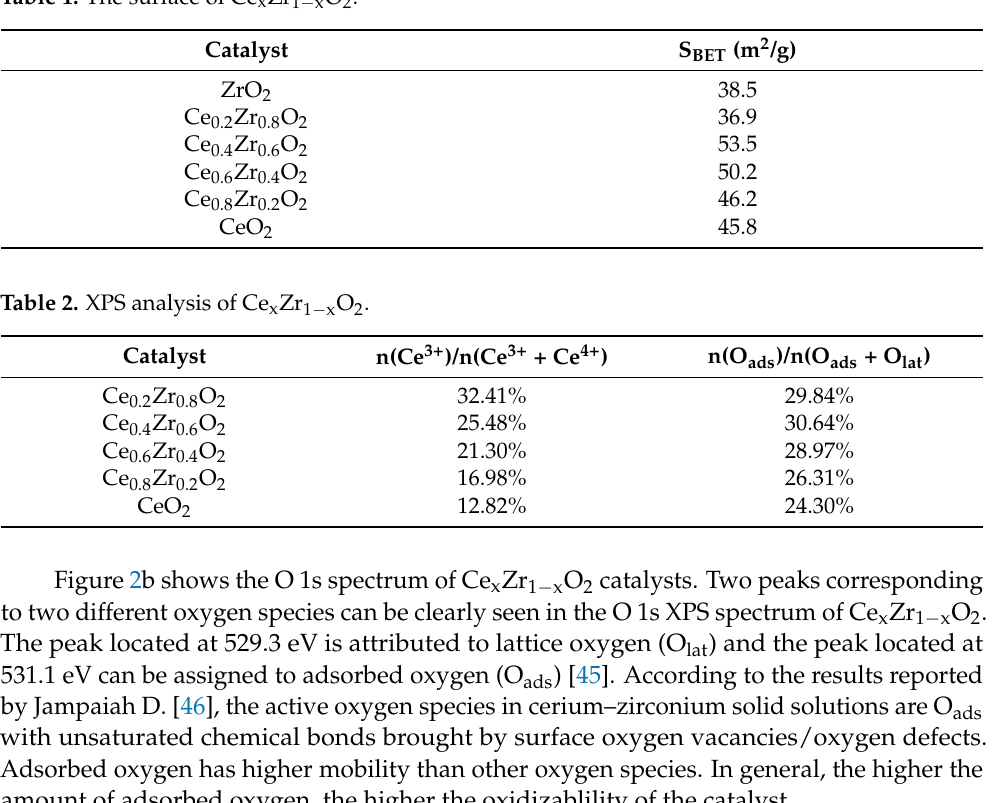
Table 1. The surface of Ce x Zr 1 − x O 2 .